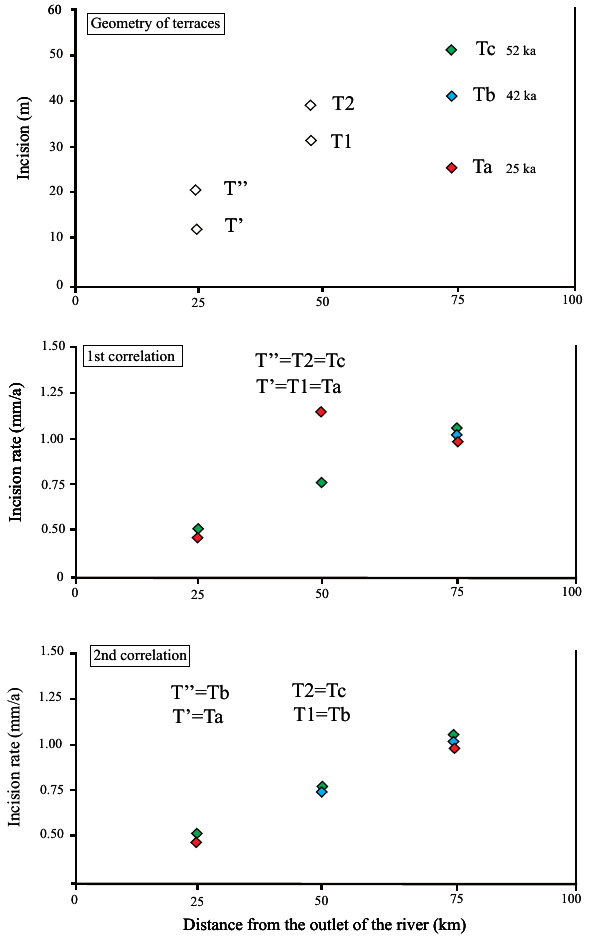
Figure 5. Idealized correlation of remnants of river terraces be- tween distant reaches of the river using an incision rate diagram. In this idealized example, the river does not cross active faults, ho- mogeneous bedrock is present along the river valley and the inci- sion rates at the different reaches have been different but constant over the analyzed time. (a) Geometry of terraces. Different num- bers of terraces are identified along the river valley. Terrace ages are provided for the three terraces located at km 75. (b) In the first cor- relation, terraces located at km 25 and 50 are correlated with the highest and lowest terraces of km 75. Anomalous value for the in- cision rate of the terrace T2 located at km 50 allow identifying that the correlation proposed is probably erroneous. (c) In the second correlation, terraces located at km 25 are correlated with the high- est and lowest terraces located at km 75, while terraces located at km 50 are correlated with the intermediate and the lowest terraces located at km 75. The similarities between the values of the inci- sion rates in the diferent reaches indicate that the correlation pro- posed is coherent.